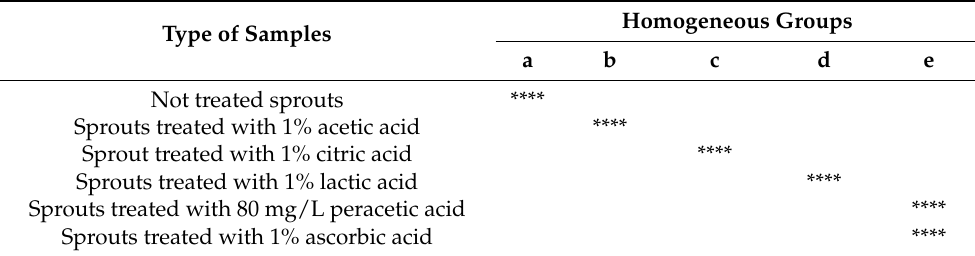
Table 2. Group homogeneity test ( α = 0.05) comparing the effect of applied organic acids on the content of polyphenols (TPC) in red cabbage sprouts subjected to 7-day